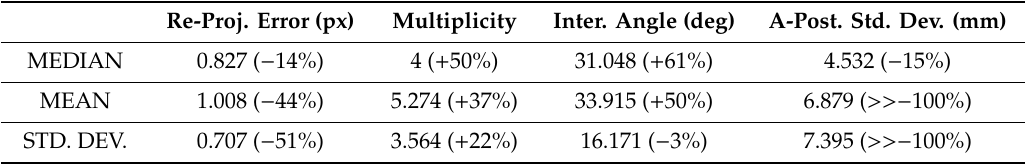
Table 5. Median, mean and standard deviation values for the quality features values computed on the filtered sparse point cloud (ca 280,000 3D tie points).